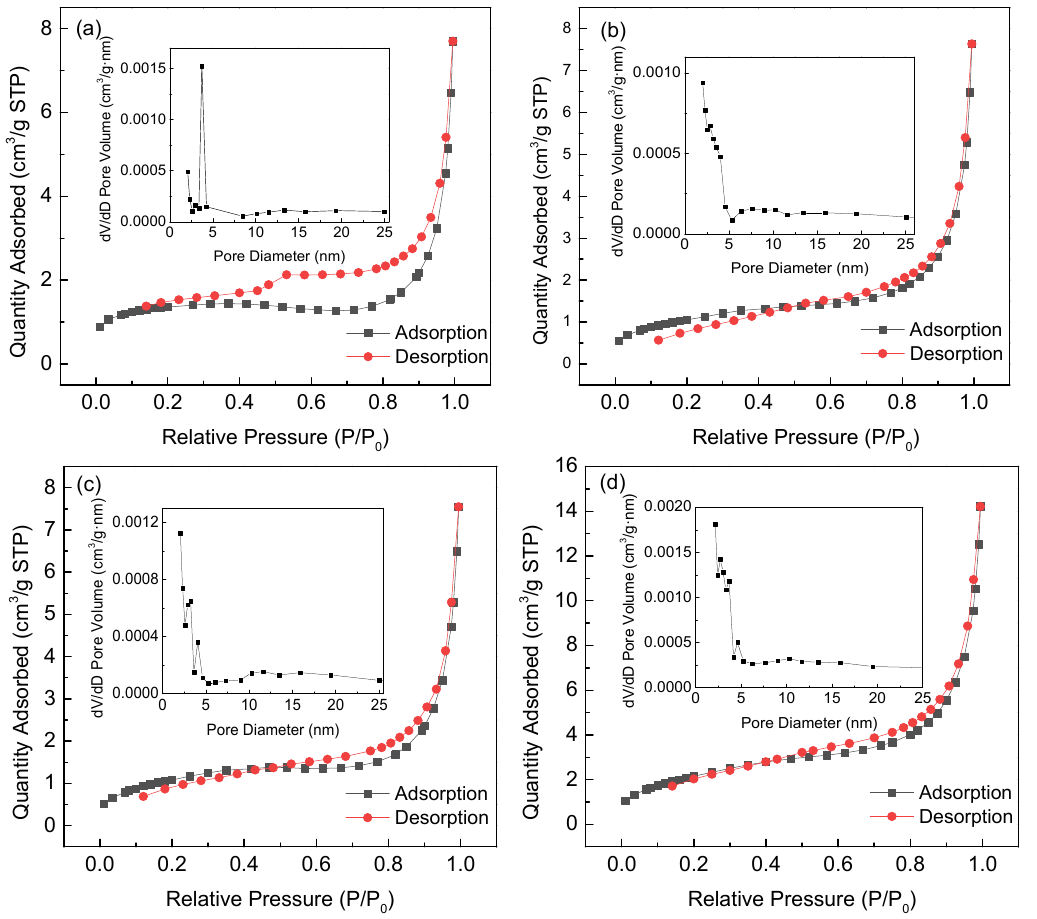
Figure 3. N 2 adsorption–desorption isotherms and pore size distribution of ( a ) S1, ( b ) S2, ( c ) S3 and ( d ) S4. ( a ) was reproduced from Ref. [8] with permission from Elsevier.